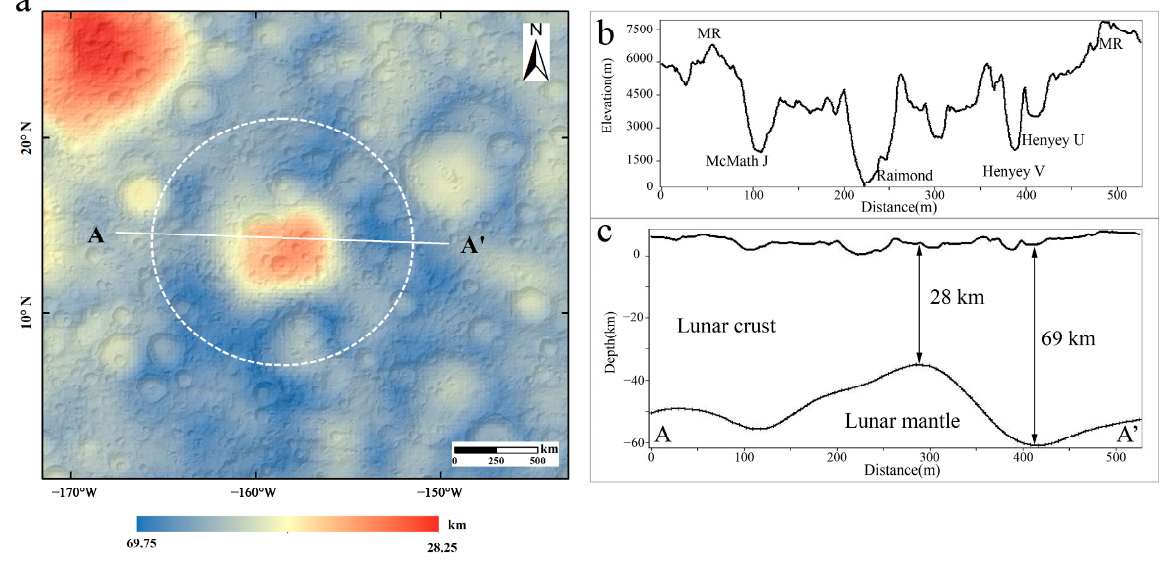
Figure 5. ( a ) Crustal thickness map of Dirichlet–Jackson Basin with shaded relief topography; ( b ) topographic profile from A to A’ based on SLDEM, where MR means the Main Rim of the basin; ( c ) subsurface characteristics of the Dirichlet–Jackson Basin along the AA’ profile.